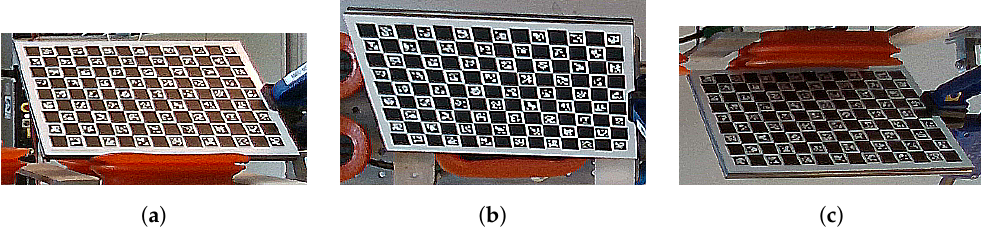
Figure 11. Charuco board views from the camera positions. ( a ) Left view from camera 1. ( b ) Top view from camera 3. ( c ) Right view from camera